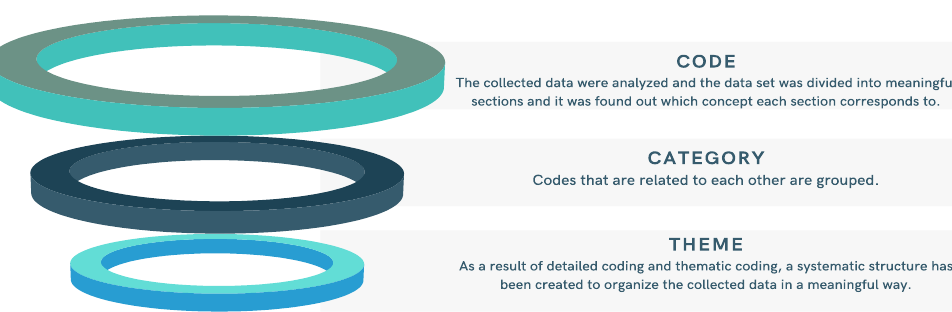
Figure 1. Organizing data by codes, categories, and themes.